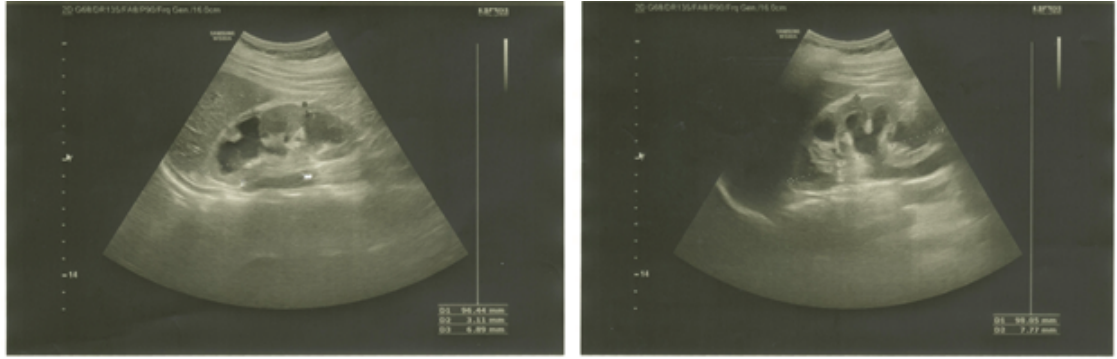
Figure 4. Abdominopelvic sonography in case V.3 showing severe hydronephrosis in both kidneys.